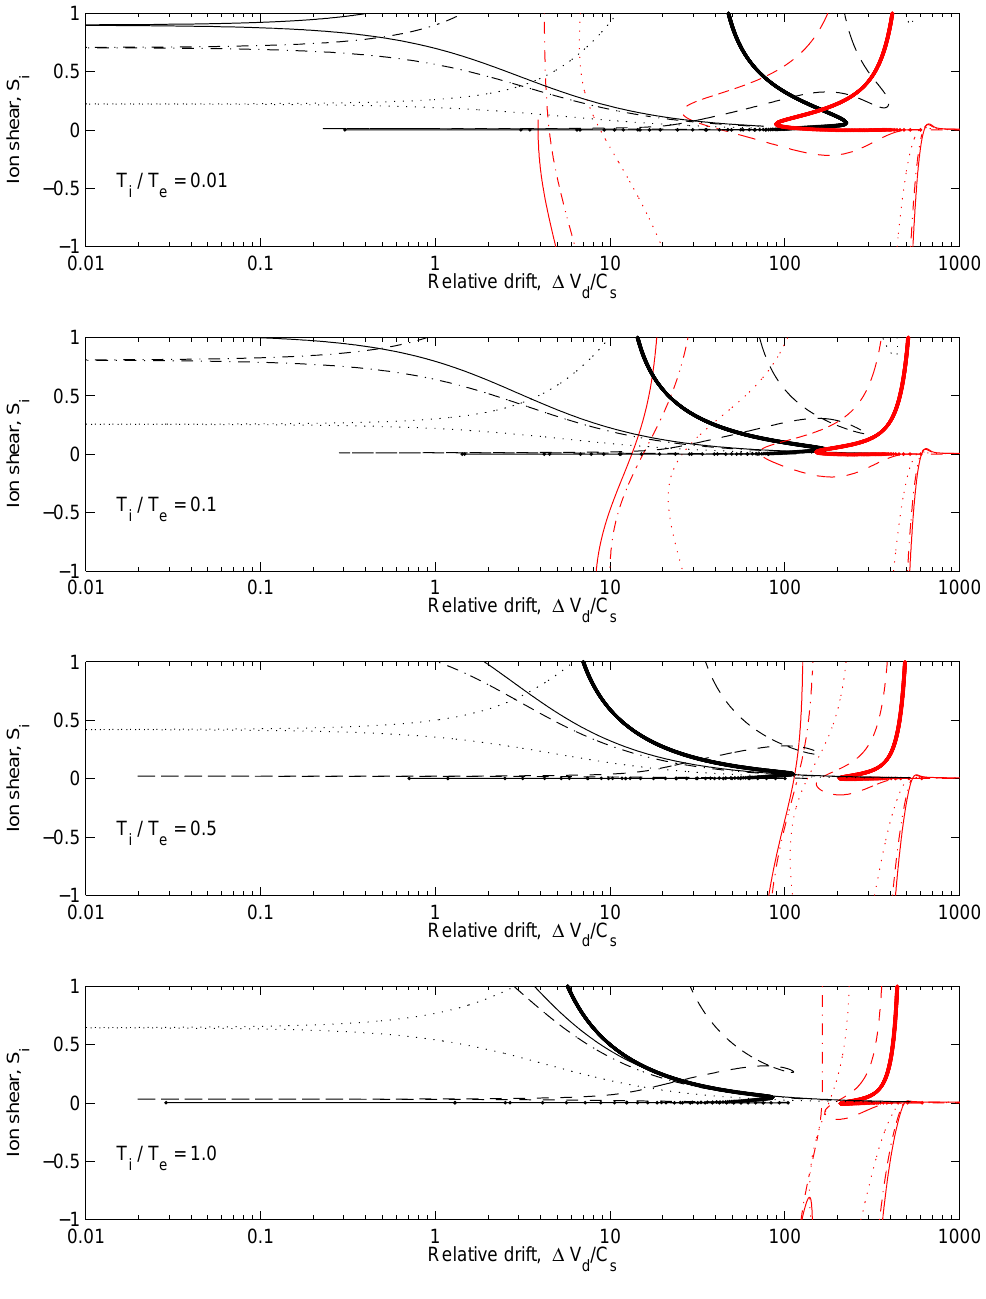
Fig. 3. Threshold conditions obtained using the kinetic dispersion relation Eq. (1) for T i /T e = 0 . 01 top panel, T i /T e = 0 . 1 second panel, T i /T e = 0 . 5 third panel and T i /T e = 1 . 0 bottom panel. The red traces correspond to the upper branches solutions of the threshold conditions that are shown in Fig. 4. The line scheme is the same as in Fig.